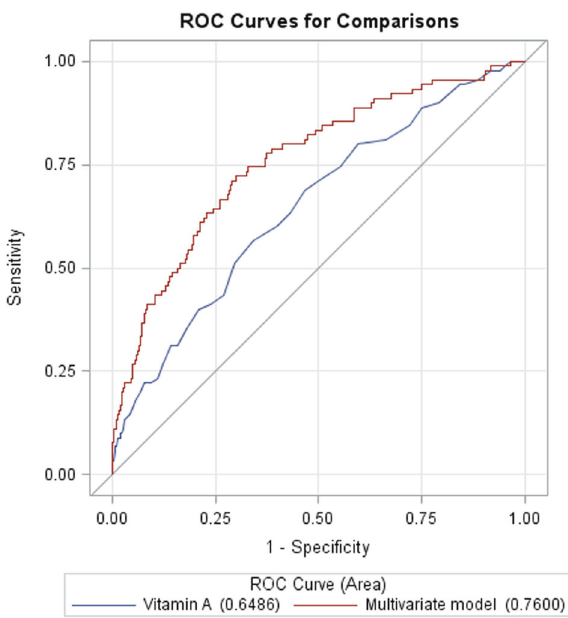
Fig. 3 ROC curves were utilized to evaluate the accuracy of the vitamin A levels in early pregnancy to predict GDM. ROC receiver operator